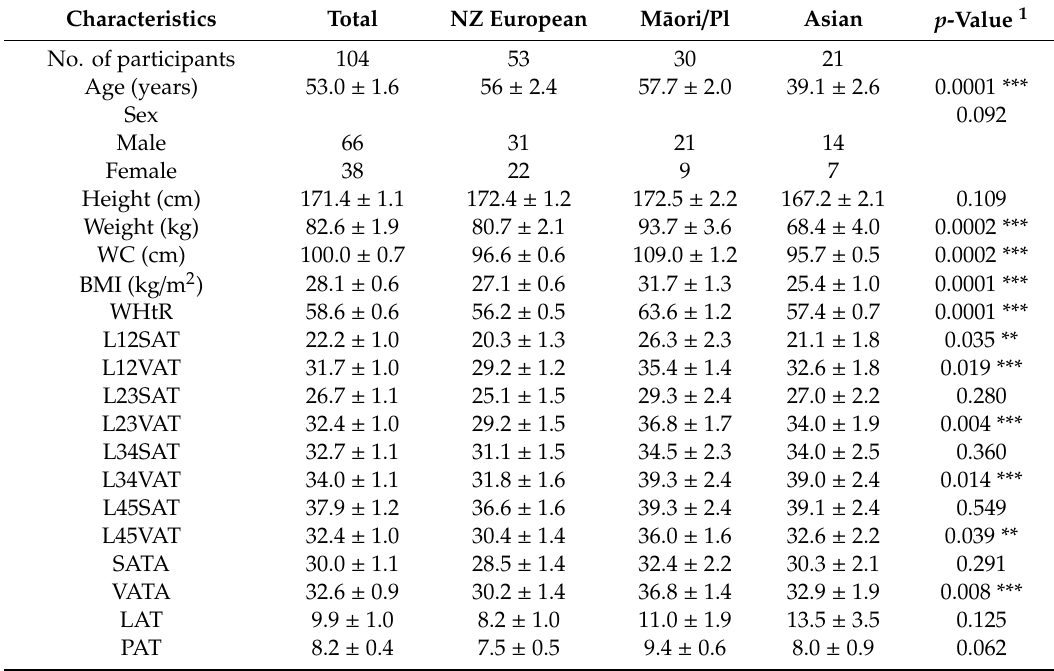
Table 1. Characteristics of study